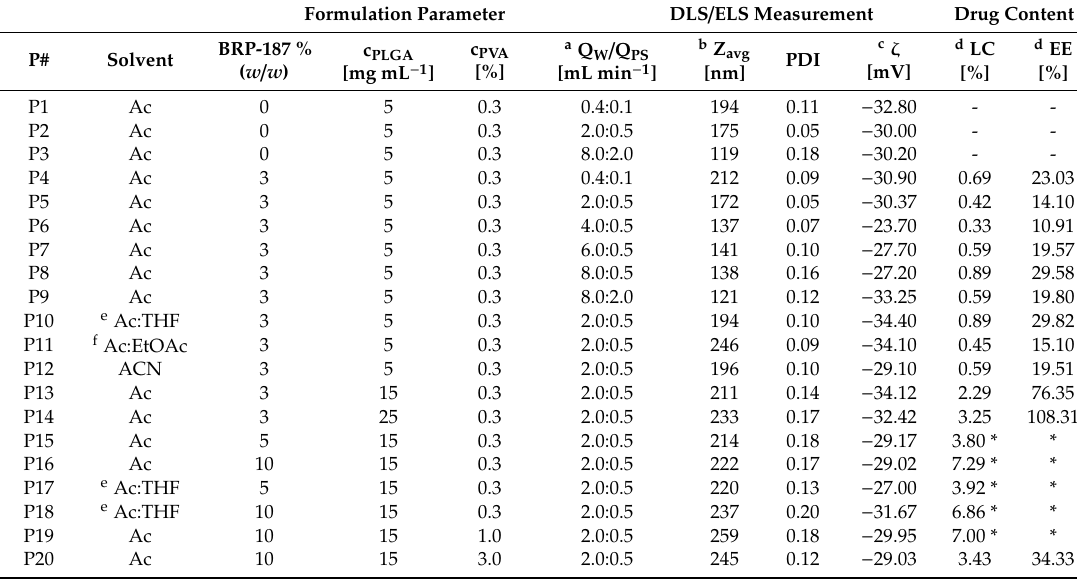
Table 1. PLGA(BRP-187) particle characteristics after formulation using di ff erent flow rates, solvents, PVA contents, initial polymer, and drug